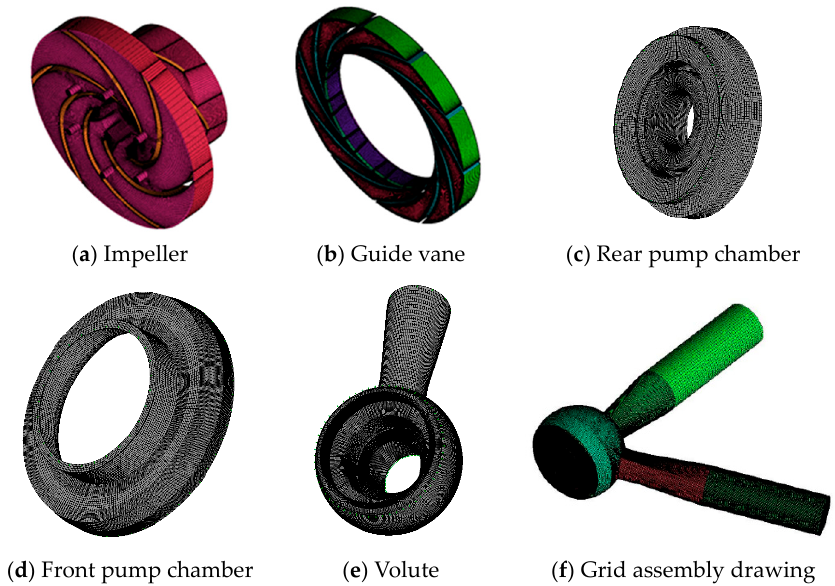
Figure 3. Flow field grid of boiler circulating pump.